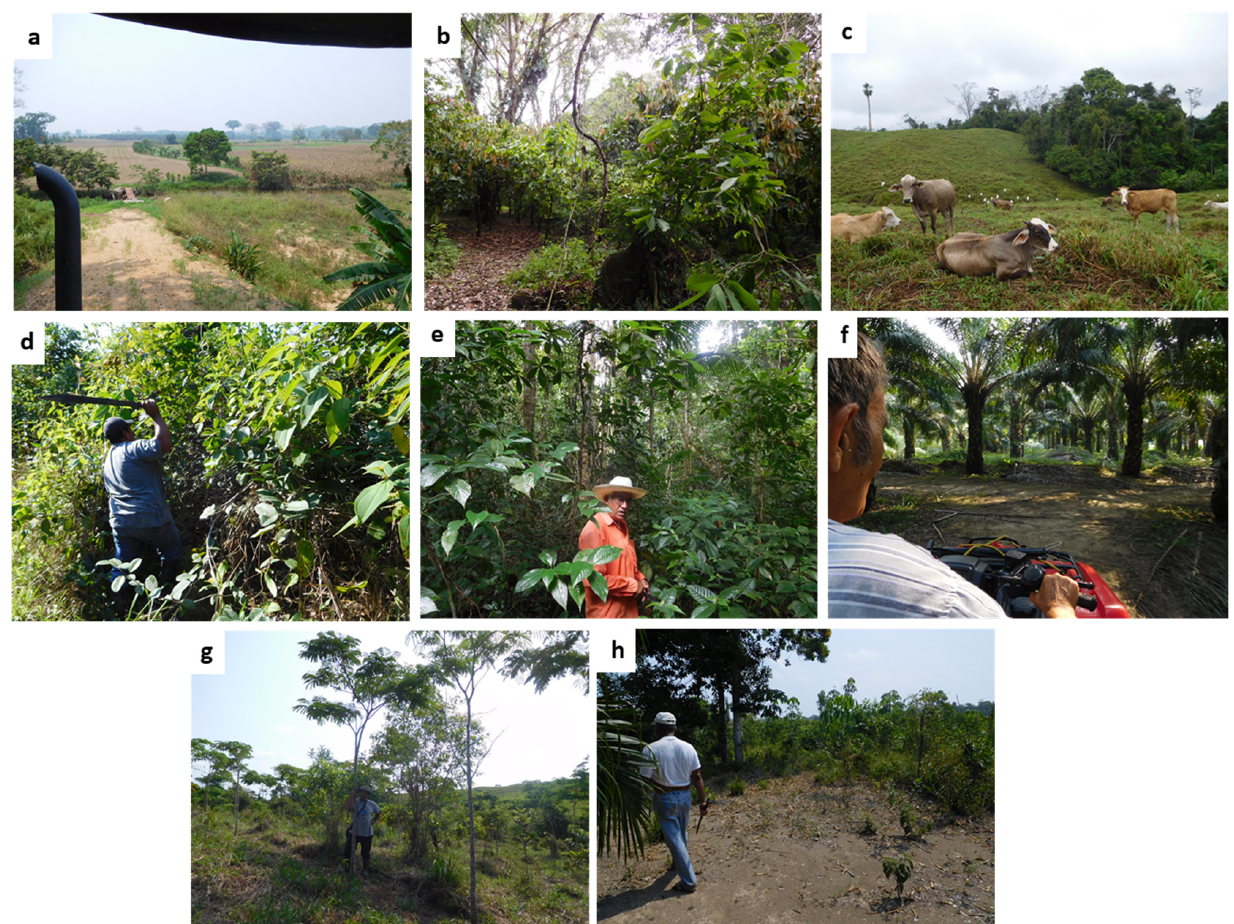
Figure 3. Representative landscapes and land-uses in the study site: ( a ) agriculture in Chajul; ( b ) cacao farm (abandoned), ( c ) pasture, and ( d ) secondary forest in Loma; ( e ) primary forest, ( f ) oil palm, ( g ) reforestation, and ( h ) rubber in Chajul. Source: all photographs taken by first author during fieldwork